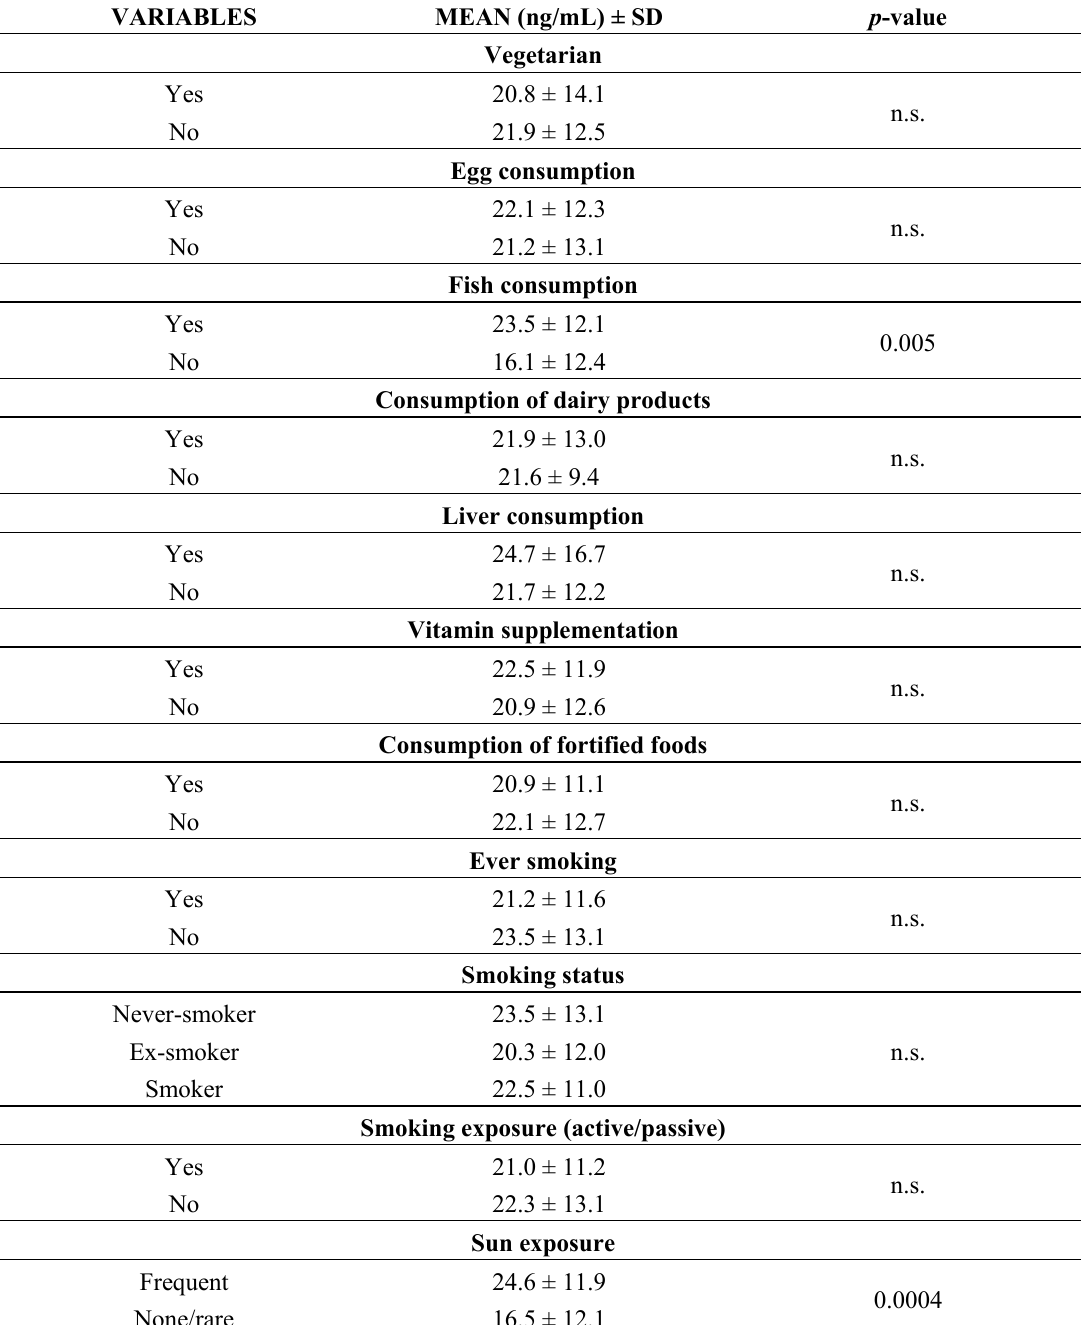
Table 6. Vitamin D levels (expressed in ng/mL) according to smoking habit, diet, sun